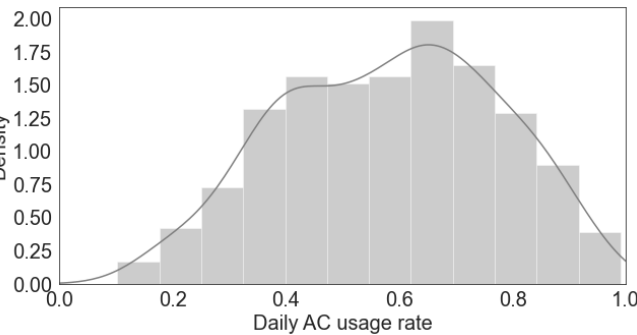
Figure 5. Density distribution of daily average AC usage rate across the 482 investigated dwellings.